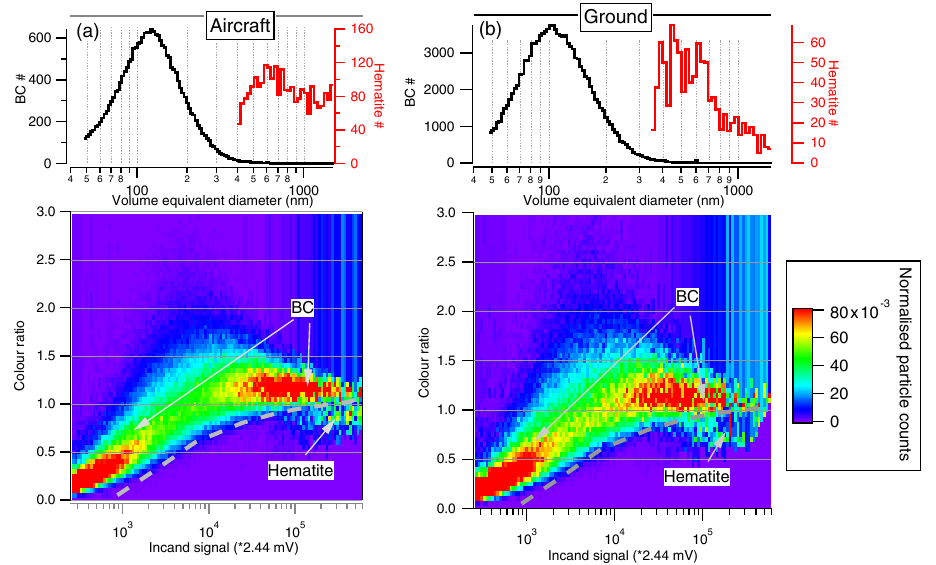
Figure 3. The colour temperature distribution as a function of broadband incandescence signal as coloured by particle number density, for aircraft (a) at 1km altitude on 12 August and ground measurements (b) on 11 August, respectively. The particle density is normalised by the total particle number at each incandescence signal bin. The top panels show the extracted BC and hematite numbers according to the dashed line on the image plots (lower